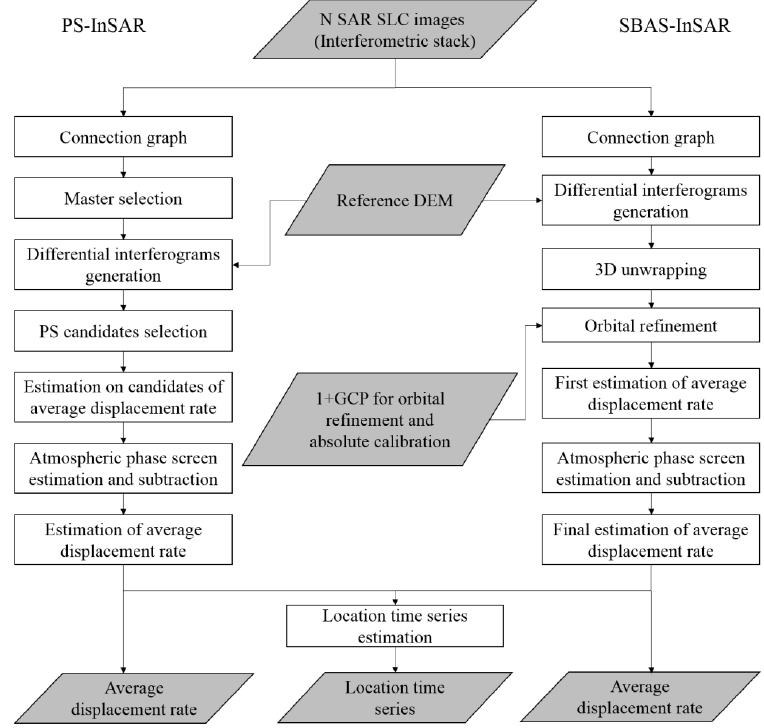
Figure 2. Logical workflow for the persistent scatterer (PS) and small baseline subset (SBAS) methods. GCP stands for ground control